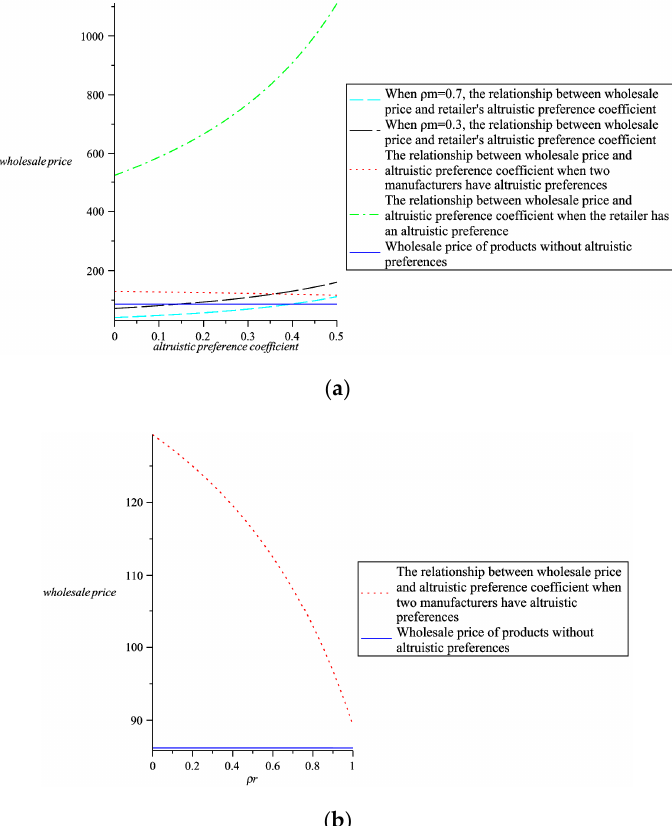
Figure 11. The relationship between wholesale prices and altruistic preference coefficients ( a ) The relationship between wholesale prices and altruistic preference coefficients in four models. ( b ) The relationship between wholesale prices and altruistic preference coefficients when two manufacturers have altruistic preferences.